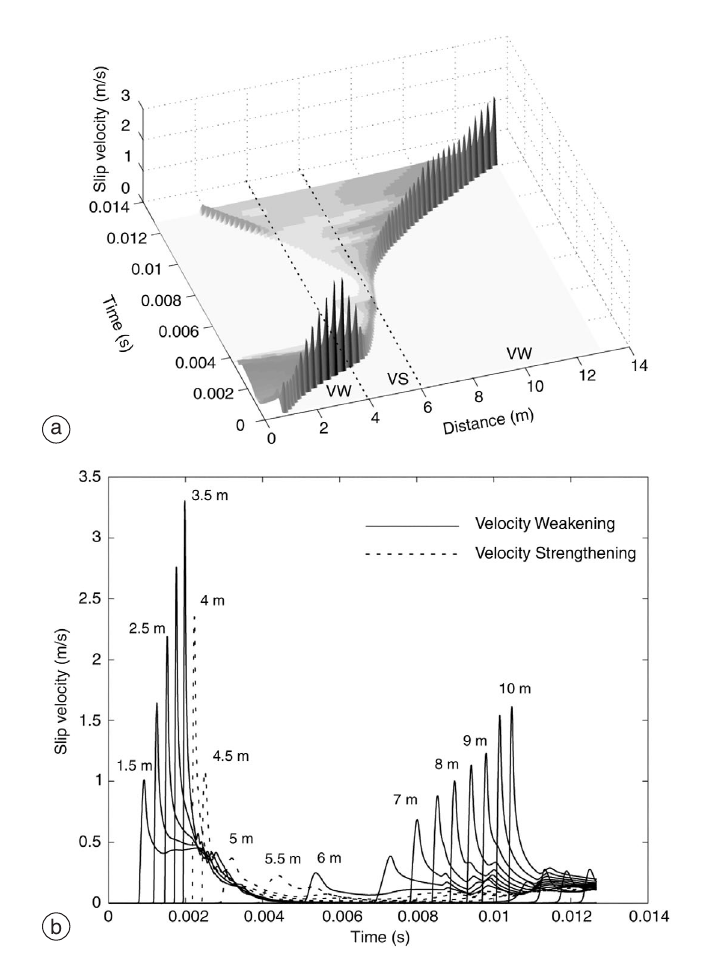
Fig. 9a,b. Dynamic rupture propagation along a heterogeneous fault: the adopted constitutive parameters are listed in table III. A narrow velocity strengthening patch separates two velocity weakening areas (identified by the values of the parameters ( a 1 , b 1 ), ( a 2 , b 2 ) and ( a 3 , b 3 ) in table III). The rupture nucleates within the inner ve- locity weakening patch. Panel a) shows the spatio-temporal evolution of slip velocity. Panel b) displays the time histories of slip velocity in different positions along the